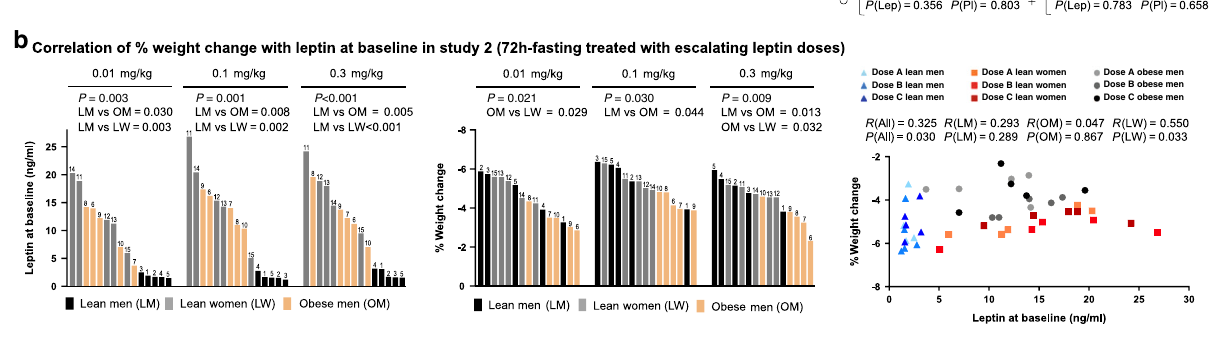
caloric intake using ad libitum feeding), energy expenditure (physical activity and resting metabolic rate (RMR) measure- ments), SNS outputs (heart rate (HR), blood pressure (BP), catecholamine levels, and the renin – angiotensin – aldosterone system (RAAS)), fuel utilization, and metabolite – lipid – lipopro- tein pro fi le.